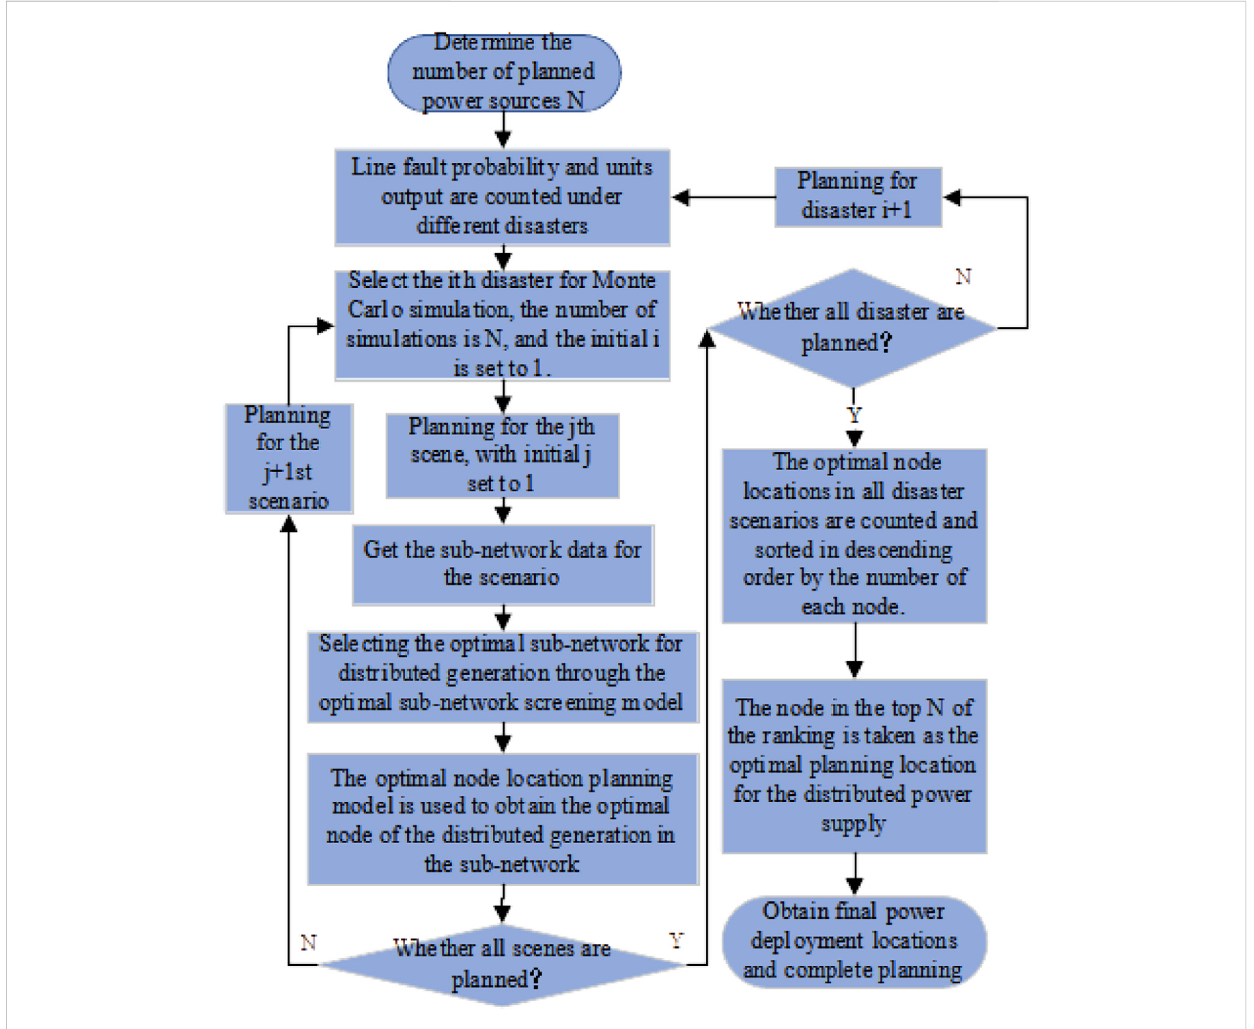
FIGURE 1 Planning fl ow chart of the proposed